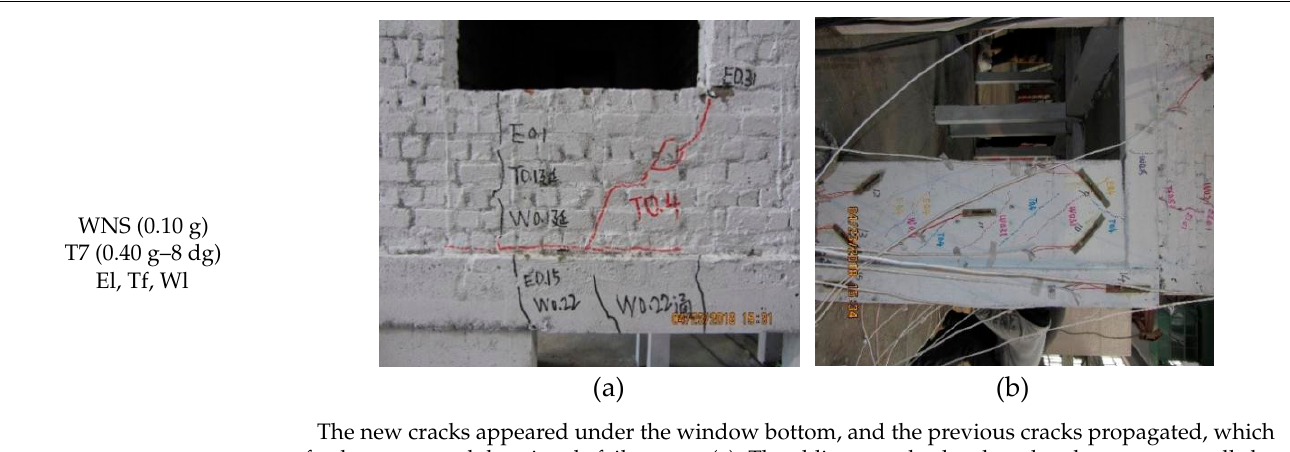
cracks developed at the masonry wall close to the pedestal of the bottom frame